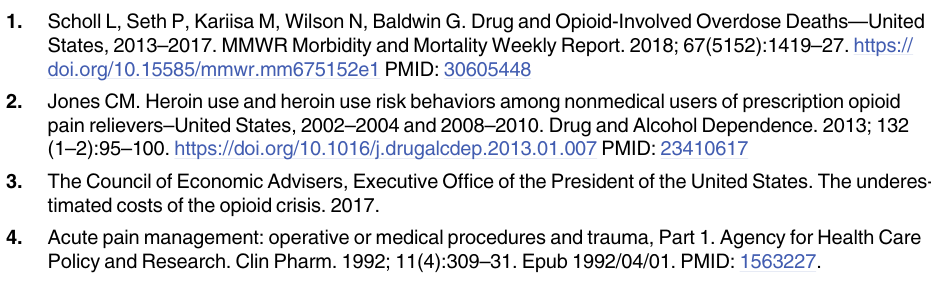
S2 Table. Opioid collaborative